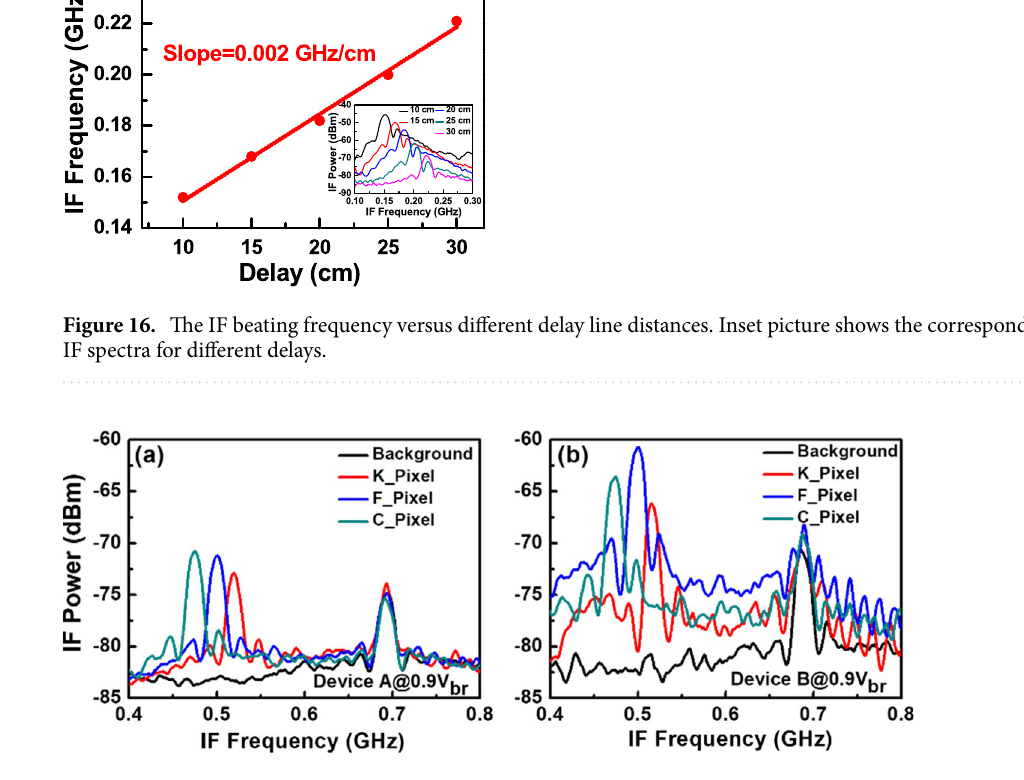
Figure 17. IF spectra of a single pixel captured from the background of the K, F and C shaped targets using APDs for. ( a ) Device A at 0.9V br . ( b ) Device B at 0.9V br